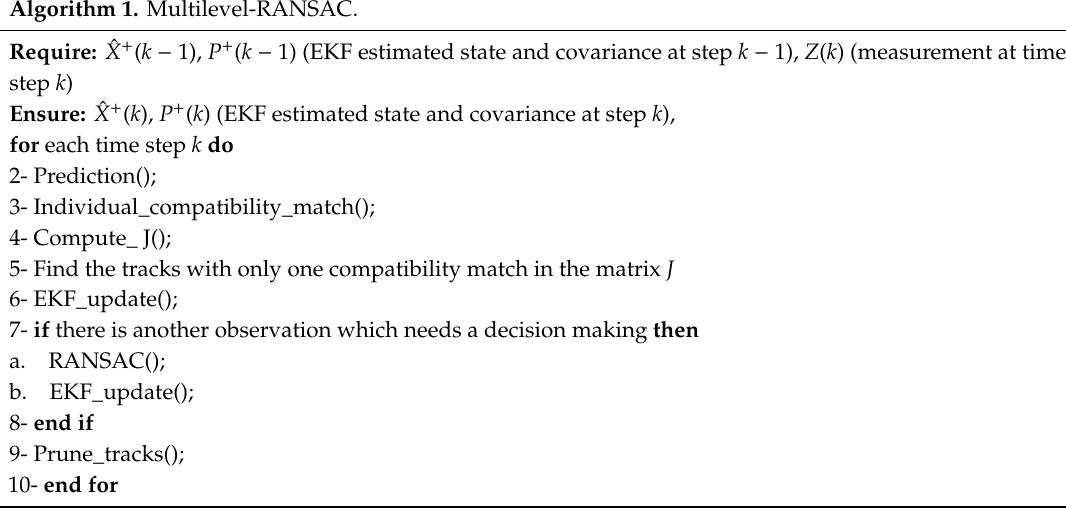
Algorithm 1. Multilevel-RANSAC.